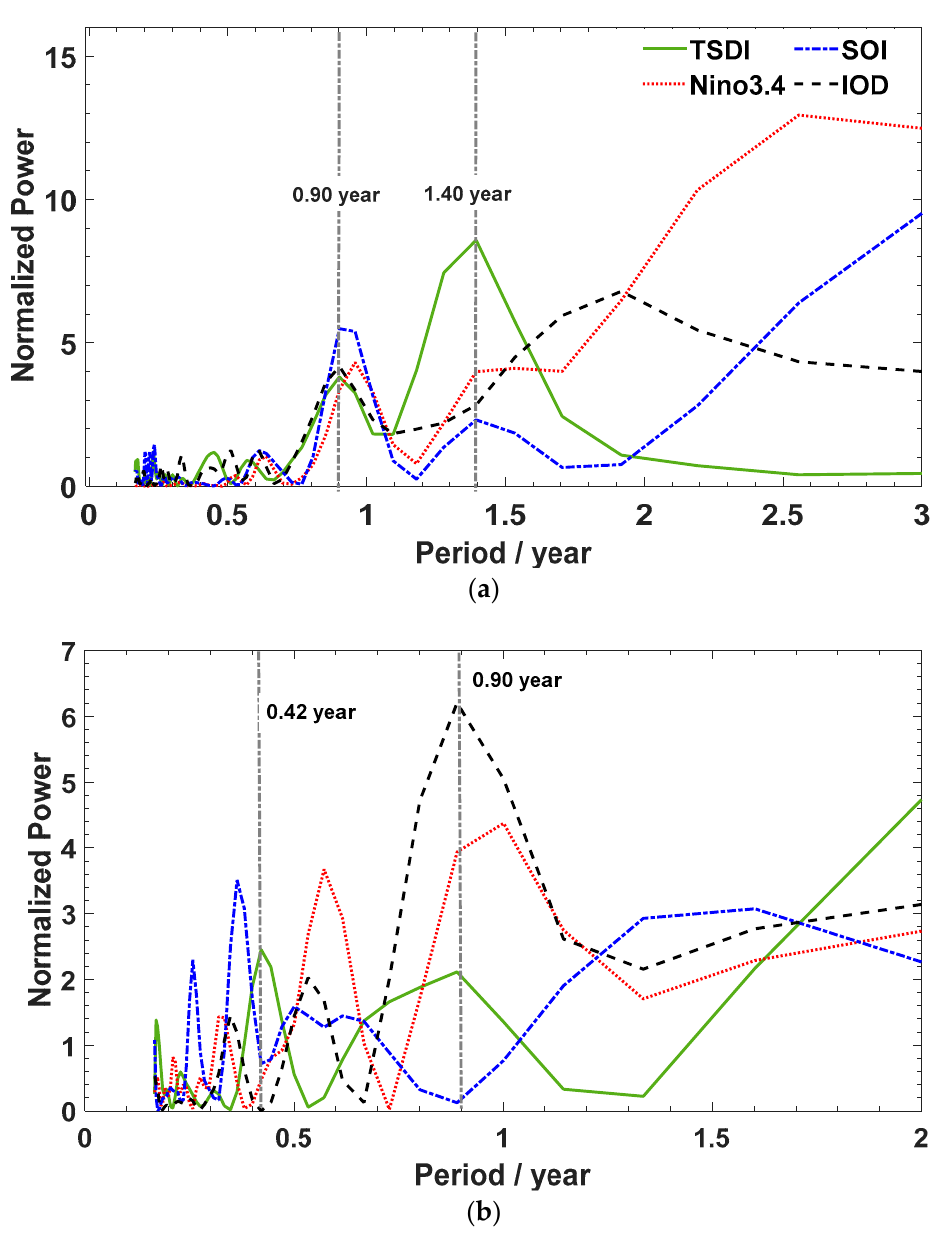
Figure 12. Power spectra of TSDI and Indo-Pacific Climate Variability indices (Nino3.4, SOI and IOD) during ( a ) Drought 2006–2009; ( b ) Drought 2018–2020 .